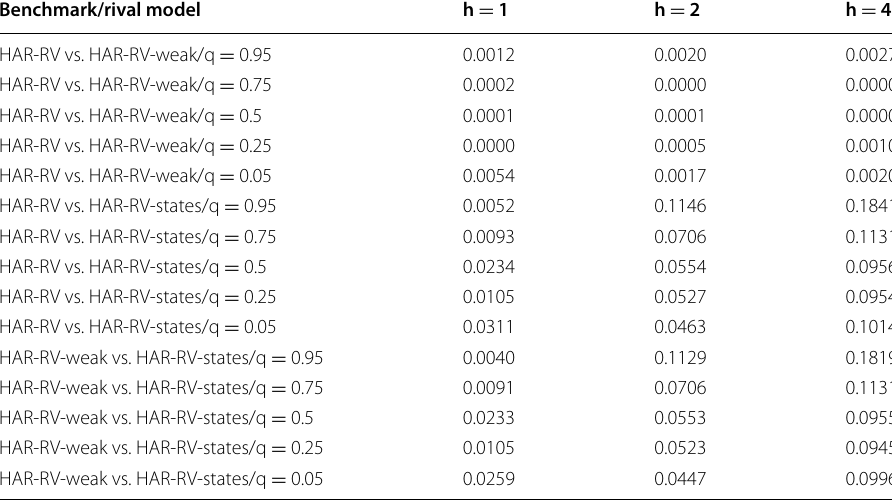
Table 6 Results for the weakness